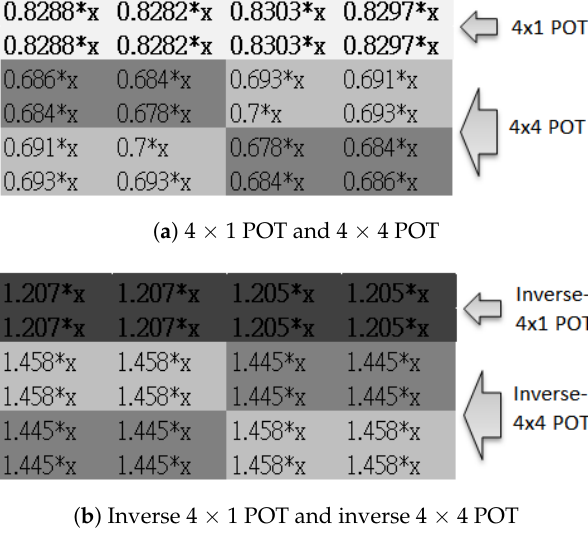
Figure 18. Border artefact distribution of 4 × 1 POT and inverse 4 × 1